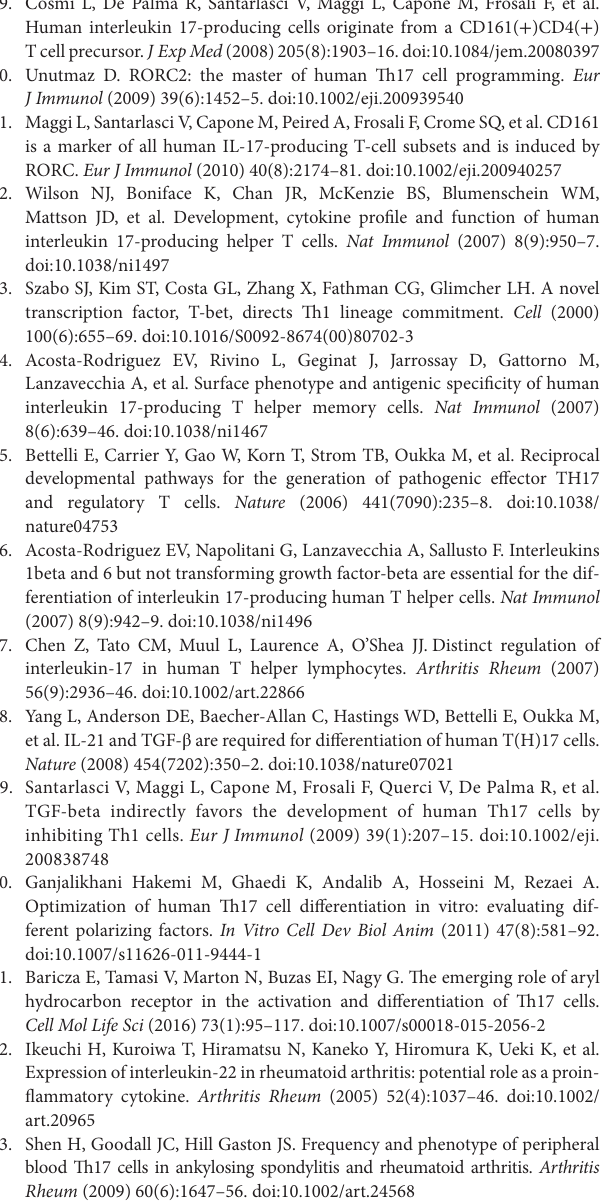
17 (Th17) differentiation of naive CD4 + T cells. Naive CD4 + T cells were stimulated and treated with cytokines as described earlier to promote Th17 differentiation. The IL-17A and IL-22 levels of cells from healthy donors’ ( n = 12), rheumatoid arthritis (RA) ( n = 9), and psoriatic arthritis (PsA) patients ( n = 7) were measured by enzyme linked immunosorbent assay method on the fifth day of the differentiation. Interdependencies were evaluated by analysis of variance and by Tukey HSD tests. The differences between healthy, RA, and PsA groups of IL-17A (a) and IL-22 (c) levels by the effect of applied cytokine treatments were indicated. FigUre s6 | Schematic representation of T-helper 17 differentiation. In addition to the IL-17A and IL-22 secretions during differentiation, the baseline and the cytokine treatment-induced transcription factor and chemokine receptor expression are distinct in both rheumatoid arthritis (RA) and psoriatic arthritis